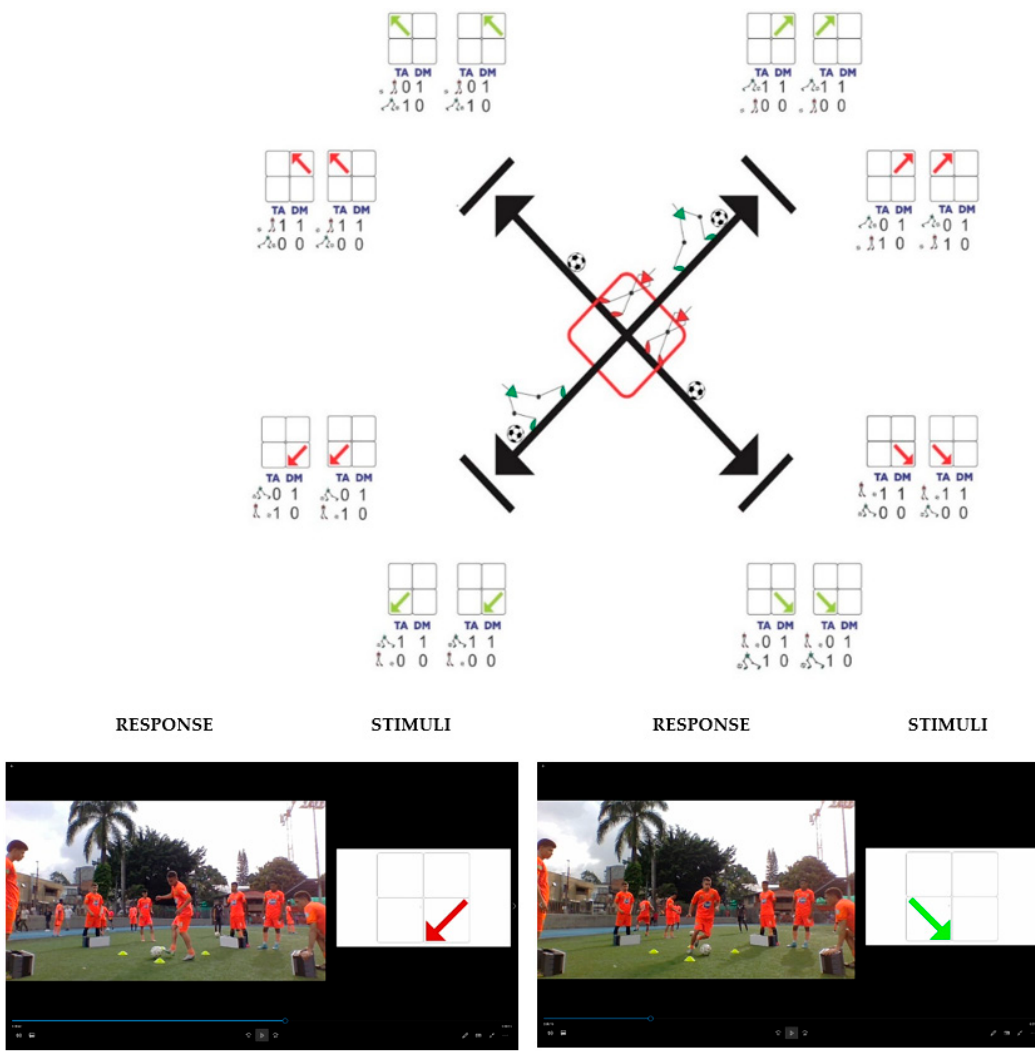
Figure 4. Examples of test grading. Good decision-making (DMA) related to the type of action (TA) and the direction of movement (DM) were scored as (1), and errors for the opposite reasons were scored as (0). It should be noted that a lack of precision was also penalized and qualified as an error, like executing the pass out of the box. Scope: the system allows for showing a stimulation cycle randomly without follow- ing any type of statistical distribution at the time of randomization. Additionally, the date and time are recorded for each instance in which the stimulus is changed, and the total of each cycle is taken as the total of the session.